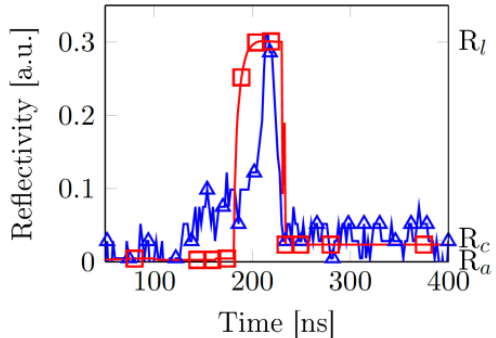
Figure 5. Simulated (red lines and squares) and measured (blue line and triangles) in situ transient reflectivity measurements for a ∆ t pulse = 160 ns PLA process with 0.56 J/cm 2 energy density ( λ = 308 nm). The initial system is a ≈ 50 nm thick amorphous Ge film on a large crystalline Ge substrate. R l , R c and R a indicate the relative reflectivity level for the liquid, crystalline and amorphous phases of the material, respectively. The additional laser probe for the reflectivity measurements has a 635 nm wavelength [42].